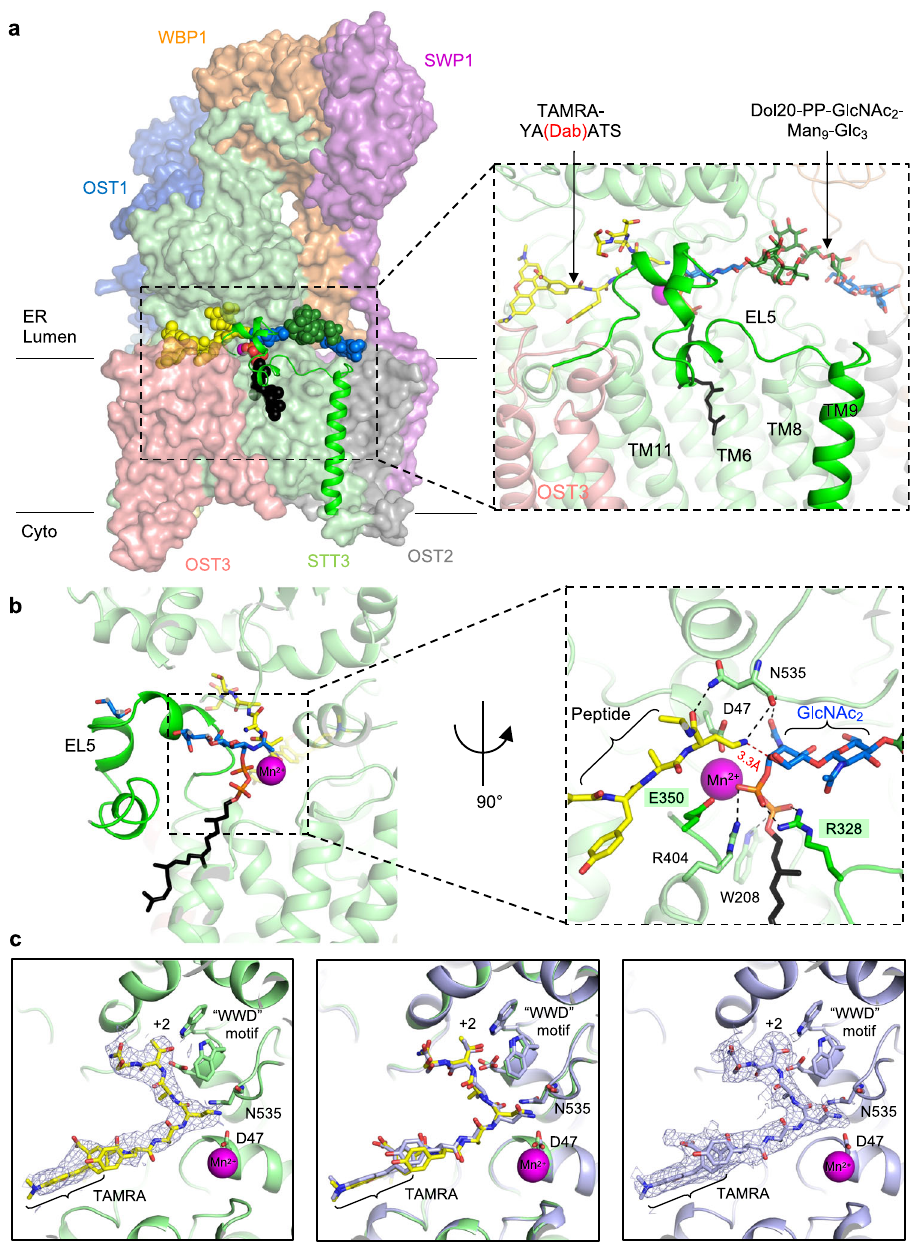
Fig. 3 | Structure of a ternary complex of OST. a OST is shown in surface repre- sentation. Subunits are colored and labeled. Ordered EL5 and TM9 are shown in ribbon representation. Bound substratesare shown insphererepresentation. Dab- containing peptide is colored yellow. Dol20 is colored black, glucose and N-acetylglucosamine units colored blue and mannose units colored green. The inset shows a close-up view of the binding sites for acceptor peptide and LLO. Substratesareshownassticksandlabeled b .ActivesiteofSTT3,withinsetshowing a close-up view. OST is shown in ribbon representation and colored as in a . Sub- strates are shown as sticks and colored as in a . Residues involved in substrate